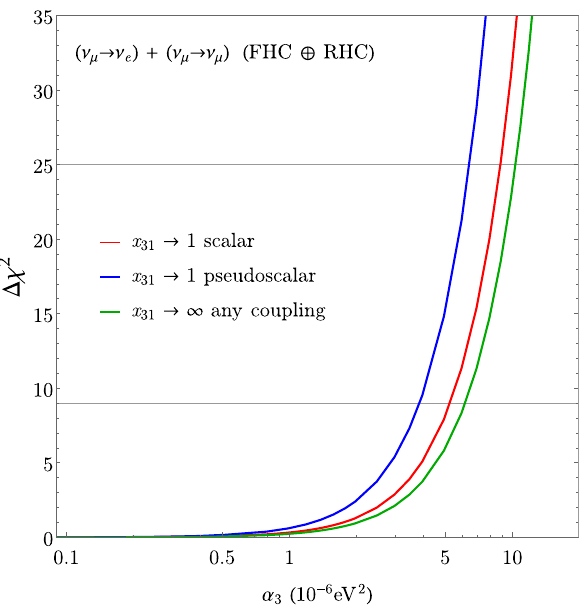
Fig. 6 Sensitivity to α 3 in DUNE, combining ν μ disappearance and ν e appearance, after both FHC and RHC runs. We marginalize over δ true and θ true . The horizontal lines indicate the 3 σ and 5 σ confidence levels 23